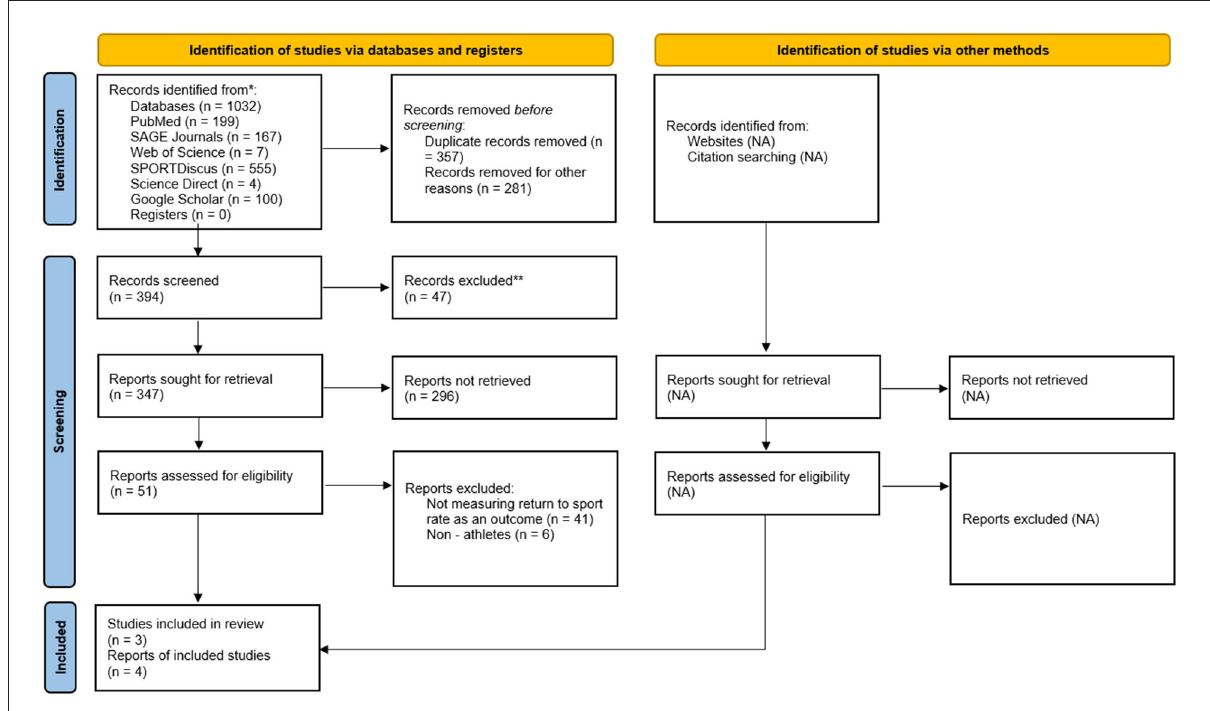
FIGURE1 Flow diagram of study selection process.